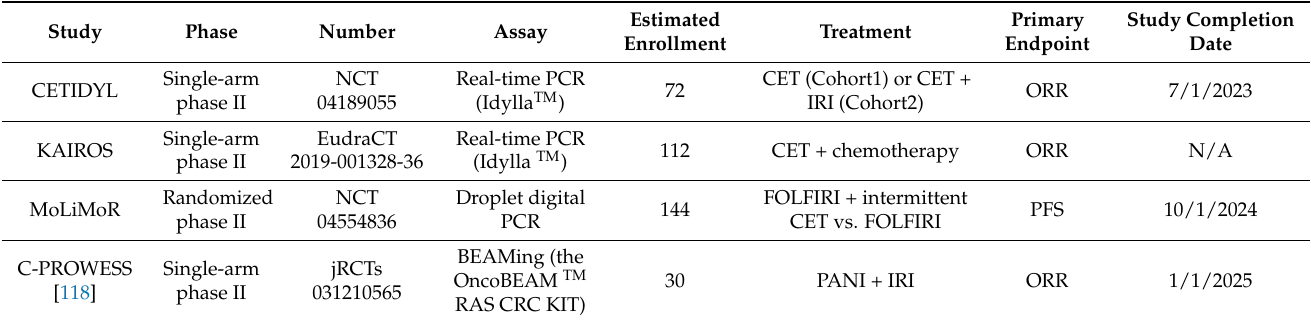
Table 3. Ongoing trials for the treatment of Neo RAS wild-type metastatic colorectal cancer.